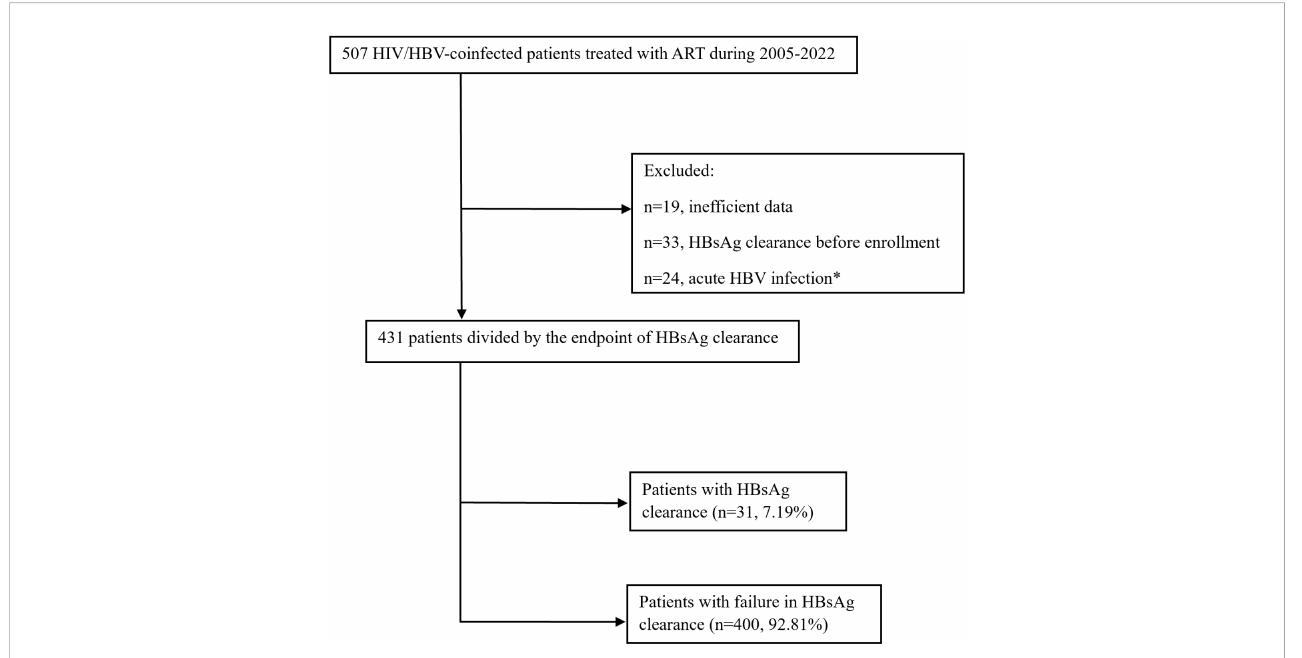
FIGURE 1 Flowchart of the study population inclusion. *Acute HBV infection was de fi ned as the persistence of HBsAg within 6